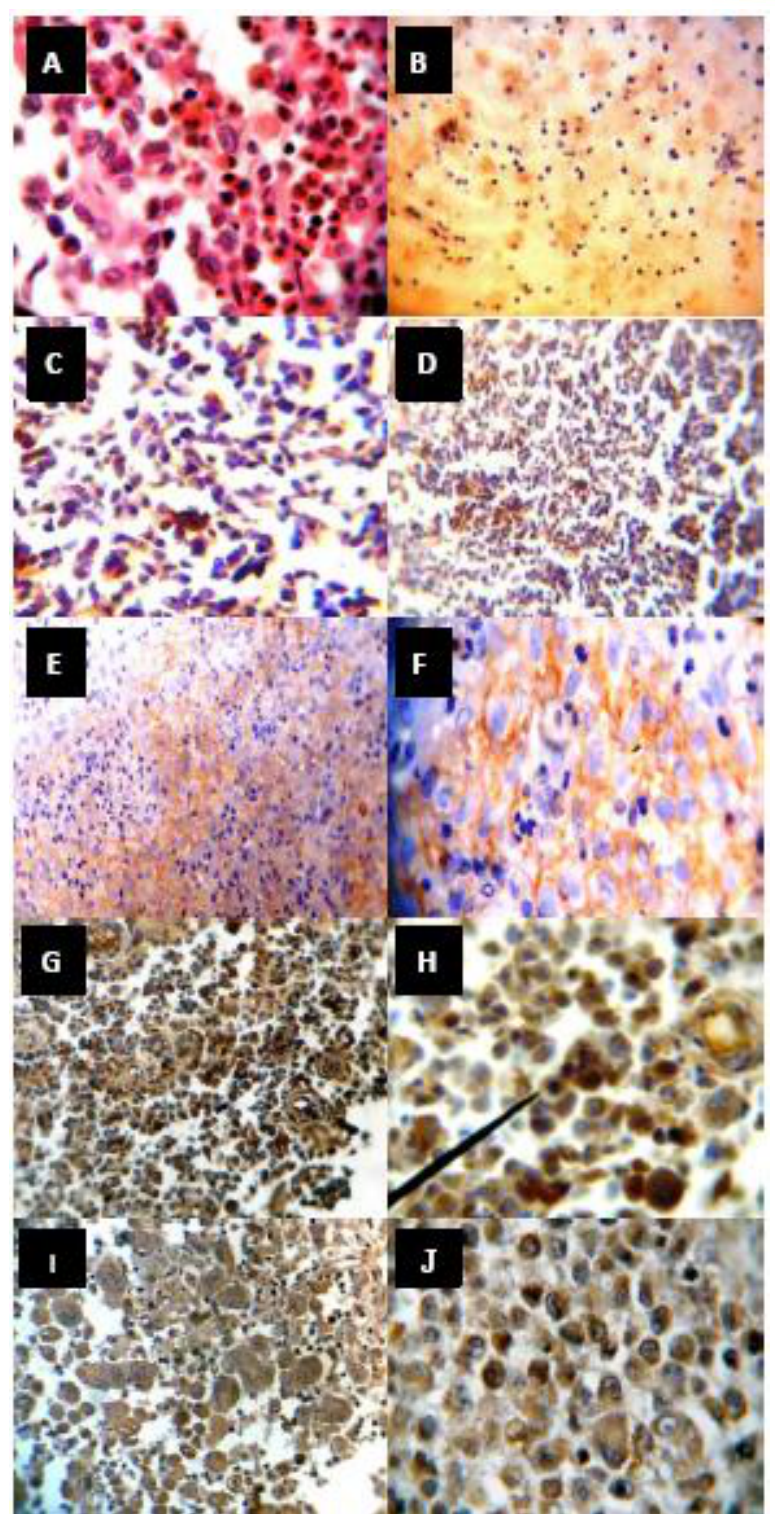
Figure 1: A: H&E Stained Photomicrograph of a Jaw LCH (40x). B: Positive Control ''Normal Brain Tissues'' for CD1a. C&D: Positive Control ''Tonsillar Hyperplesia'' for RANKL&RANK. E&F: CD1a Stain (40x objective) Demonstrating Positive Membrane Staining of Lesional Histiocytes in a Skull LCH (40x&10x).G&H: Positive Cytoplasmic Immunostaining to RANKL Antibody in a Jaw LCH(40x&10x), Pointer Showed a Mitotic Figure. I&J: Positive Cytoplasmic Immunostaining to RANK Antibody in a Skull LCH